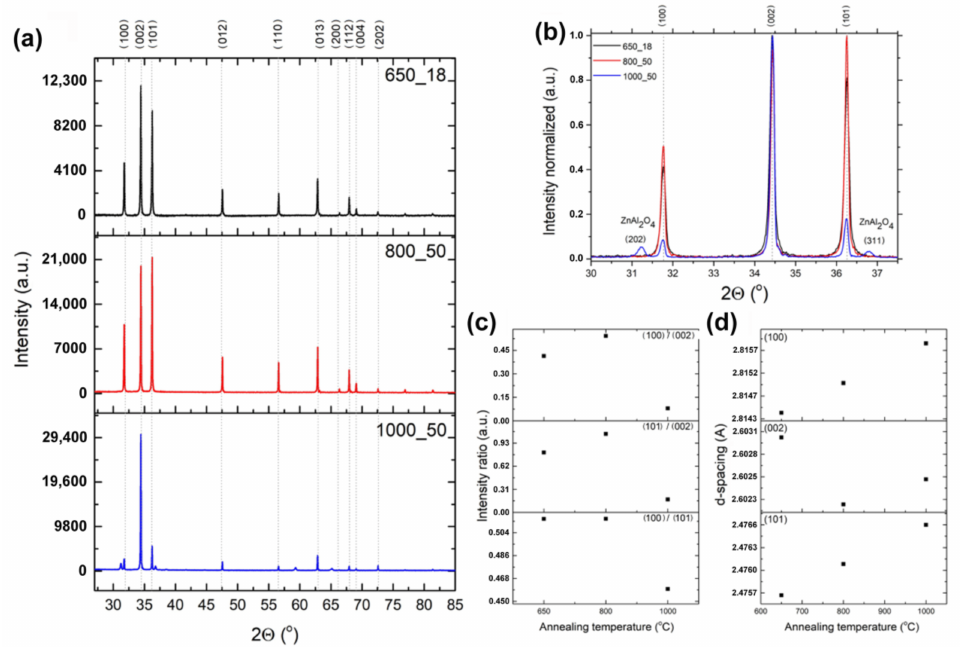
Figure 3. ( a ) XRD patterns of samples annealed at 650, 800, and 1000 ◦ C; ( b ) XRD patterns of each sample in a shorter range with the designation of another observed phase; ( c ) the ratio of intensity between the most prominent peaks; ( d ) the shifting of the most prominent peaks.